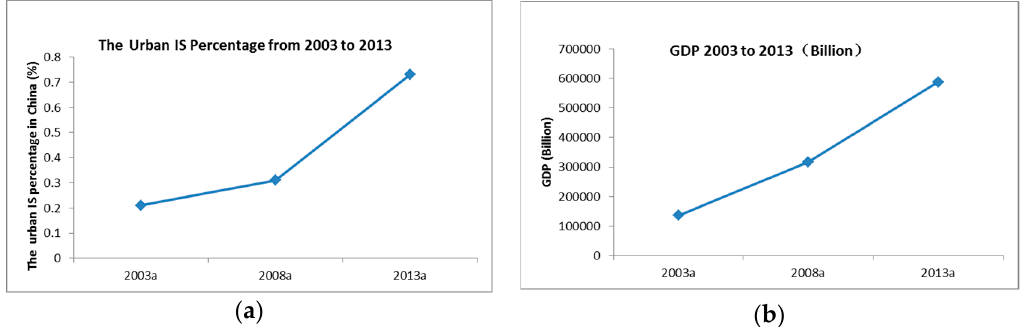
Figure 5. The change in (a) urban impervious surface percent (UISP) and (b) gross domestic product (GDP) from 2003 to 2013.